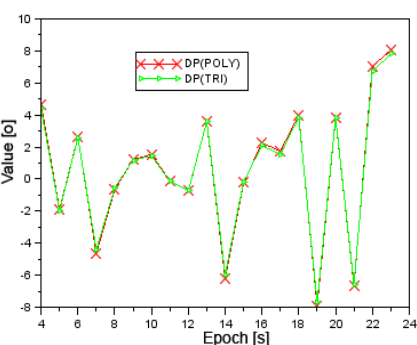
Figure 7. The values of DR parameter based on polynomial and trigonometric